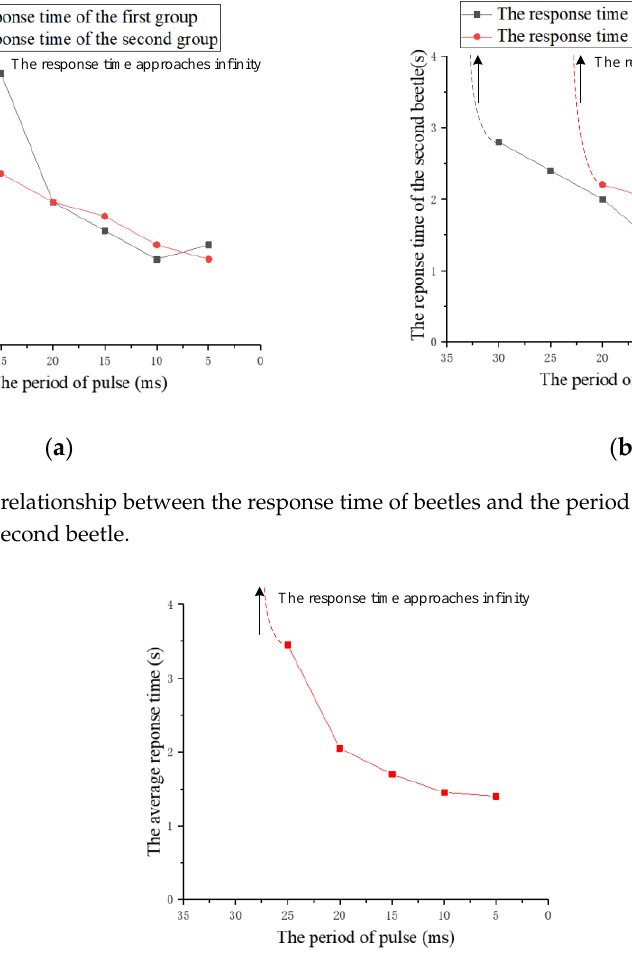
Figure 12. The relationship diagram between the average response time and the period of pulses.